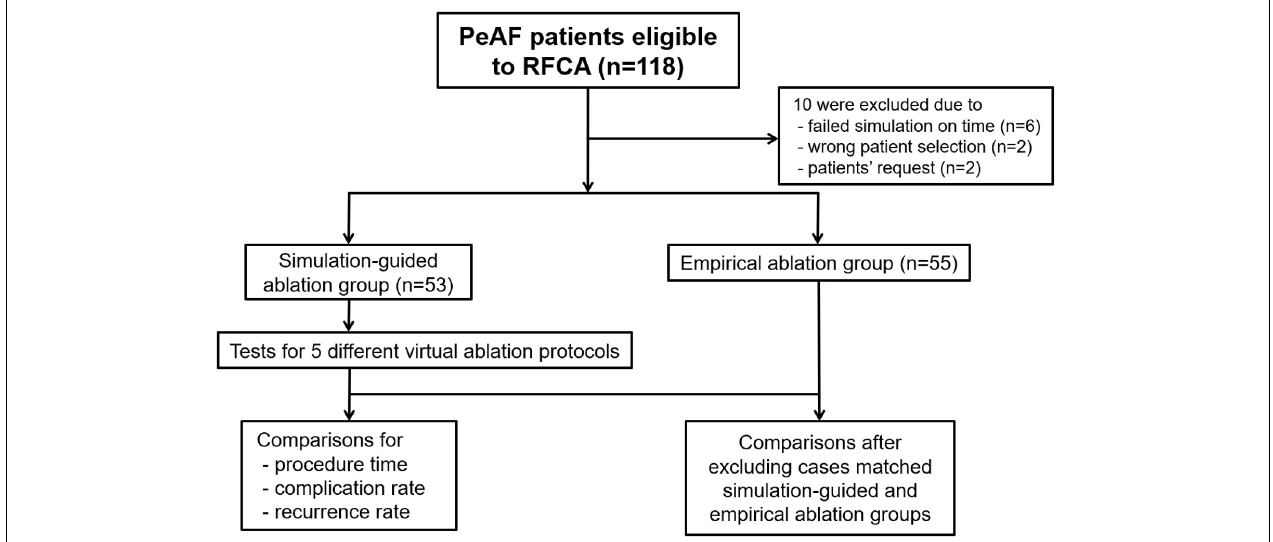
FIGURE 1 | Study flow diagram. The enrolled patients were randomly assigned to either the computational modeling-guided ablation group or the empirical ablation group. PeAF, persistent atrial fibrillation; RFCA, radiofrequency catheter